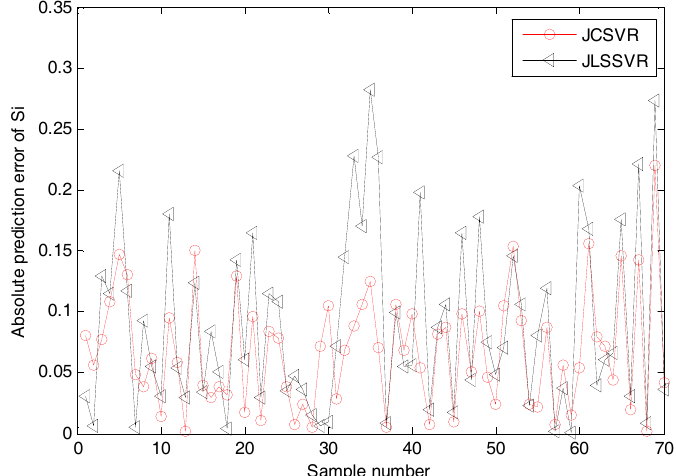
Figure 5. Comparison results of online silicon content prediction using JCSVR and JLSSVR models (test set).